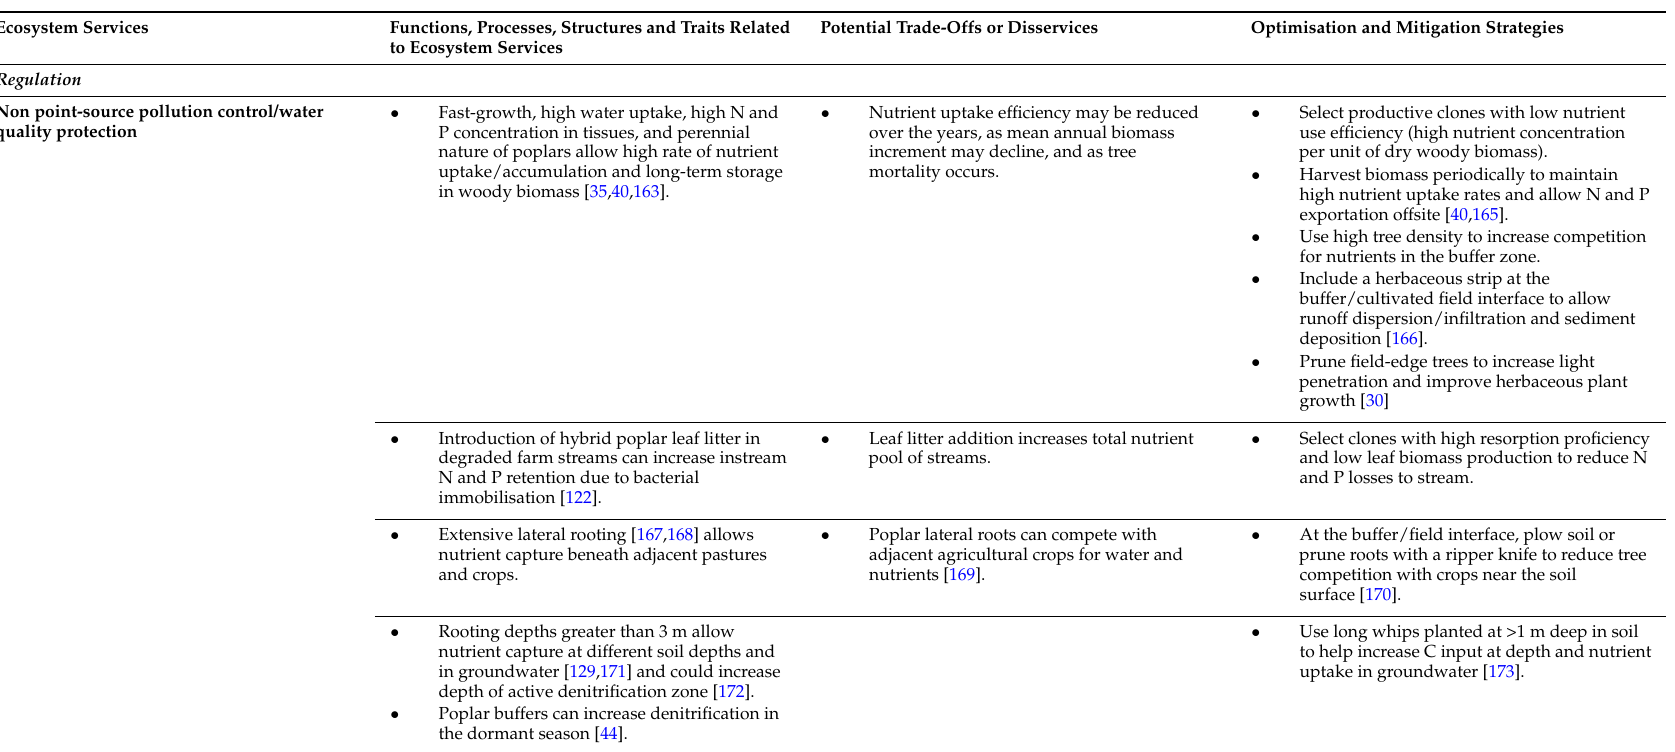
Table 10. Overview of potential ecosystem service and disservices following the replacement of non-managed herbaceous buffers by hybrid poplar buffers. Management considerations for services optimisation and disservices mitigation are also